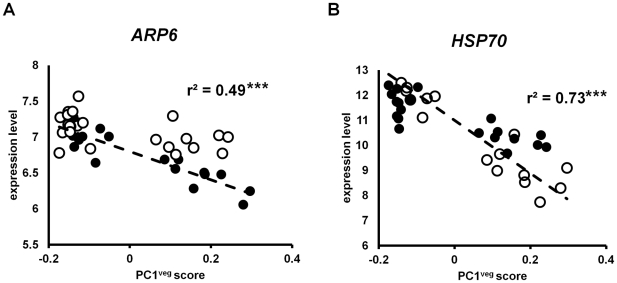
Gene expression in A. thaliana under field conditions correlated with PC1veg.Each point is the LS mean expression level of (A) ARP6 and (B) HSP70 in Bay-0 (open circles) and Sha (closed circles) for each time point. The dashed line shows the linear regression through the data. *** = p<0.001.